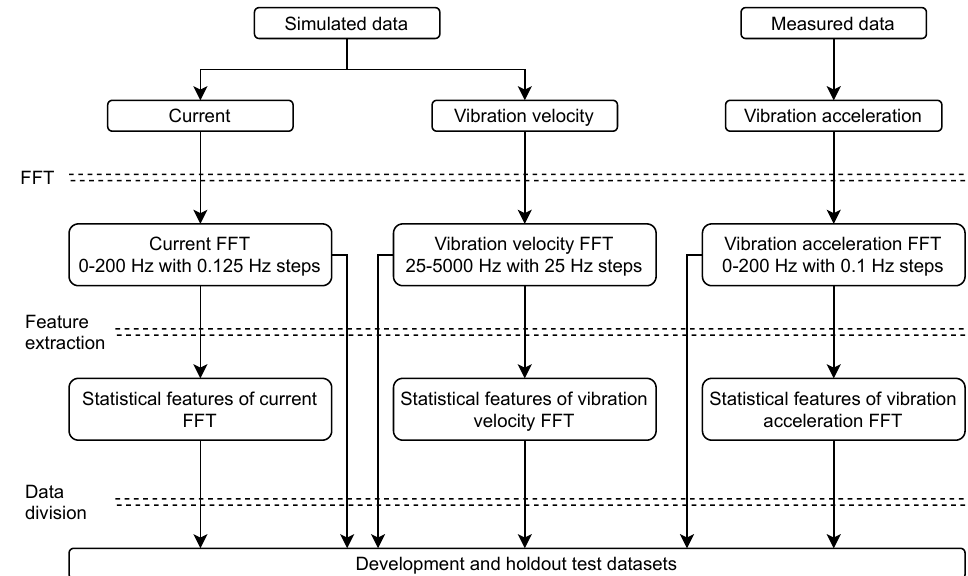
Figure 7. Overview of the data preparation